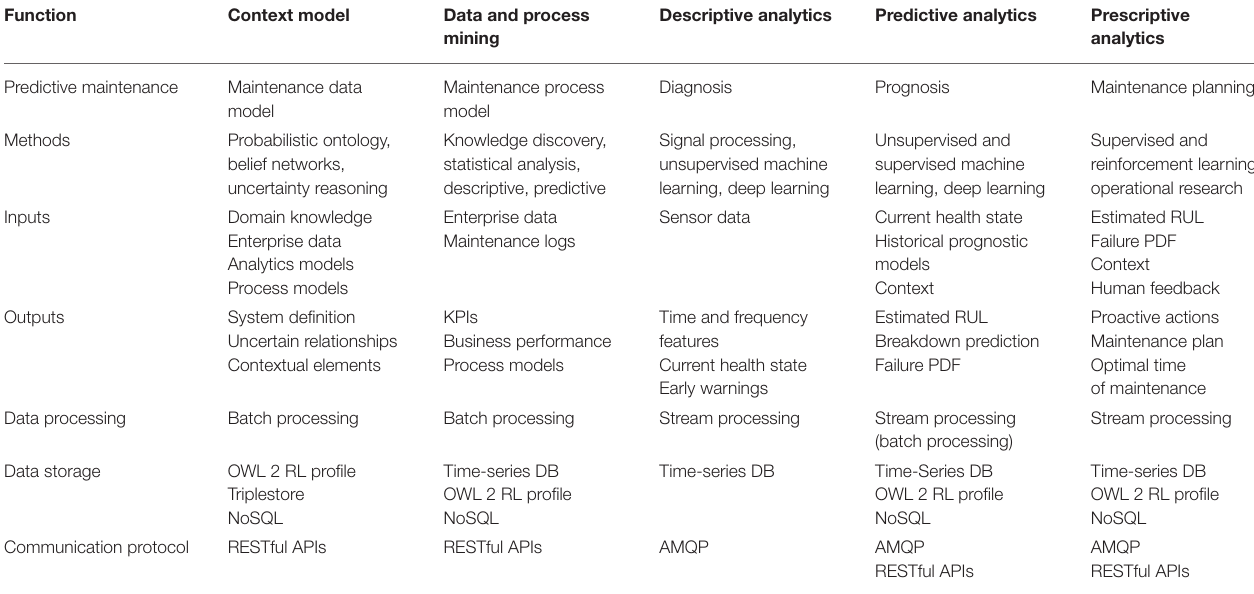
TABLE 2 | Instantiation of RAMI 4.0 functional layer to predictive maintenance.